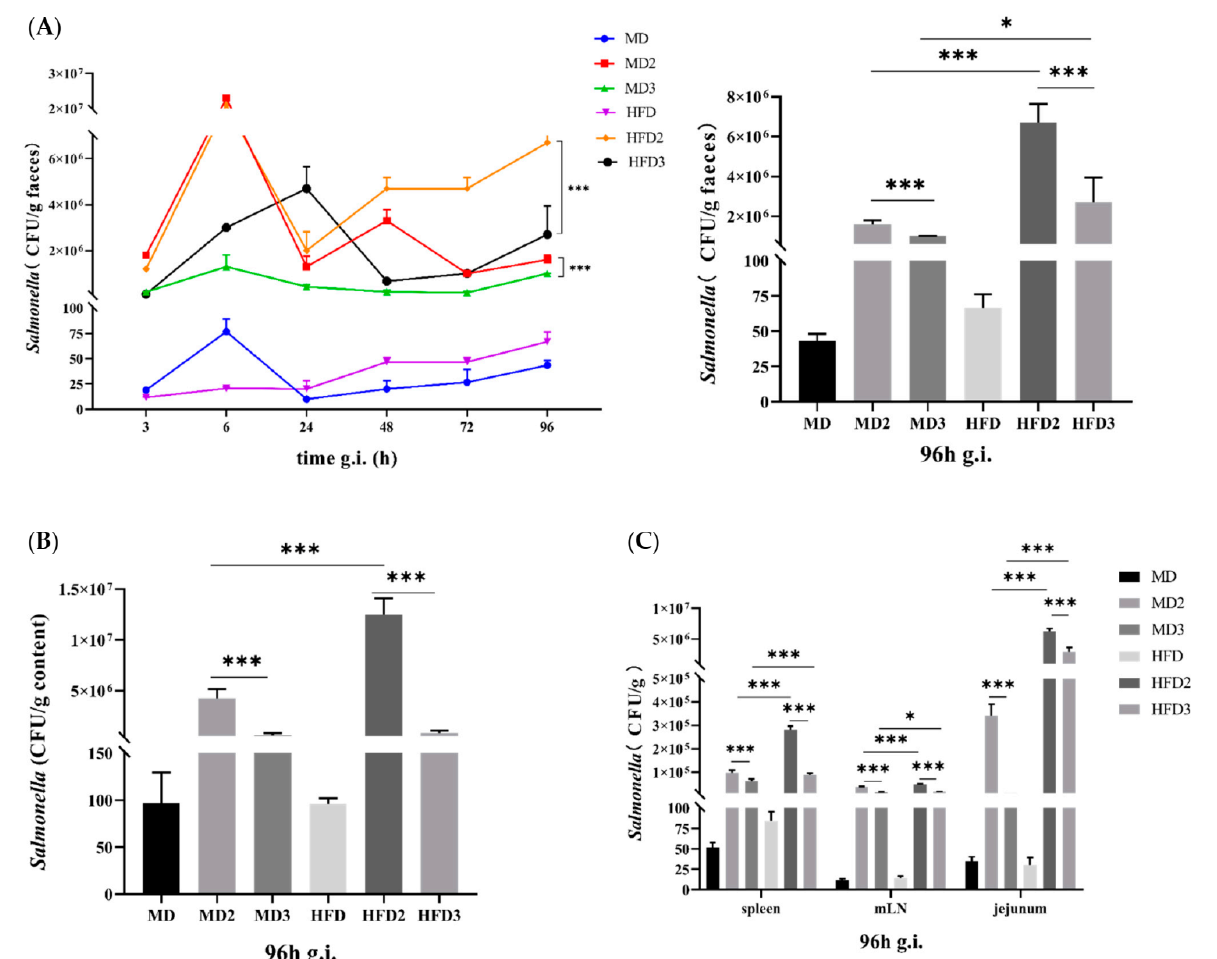
Figure 1. High-fat diet (HFD) promotes S. Typhimurium ATCC 13311 colonization while L. plantarum 1201 inhibits it. ( A ) statistical graph of S. Typhimurium content in mouse feces after gavage and the content of S. Typhimurium in mouse feces after intra-gastric administration for 96 h; ( B ) statistical graph of the content of S. Typhimurium in the colon content of mice after intra-gastric administration for 96 h; ( C ) statistical graph of the content of S. Typhimurium in mouse organs after intra-gastric administration for 96 h. * p < 0.05; *** p < 0.001; paired two-tailed t-test. MD: normal diet; MD2: normal diet and 1 × 10 8 CFU/mL S. Typhimurium ATCC 13311; MD3: normal diet, 1 × 10 8 CFU/mL S. Typhimurium ATCC 13311 and 1 × 10 8 CFU/mL L. plantarum 1201; HFD: high-fat diet (HFD); HFD2: HFD and 1 × 10 8 CFU/mL S. Typhimurium ATCC 13311; HFD3: HFD, 1 × 10 8 CFU/mL S. Typhimurium ATCC 13311 and 1 × 10 8 CFU/mL L. plantarum 1201; mLN, mesenteric lymph node; g.i., gavage